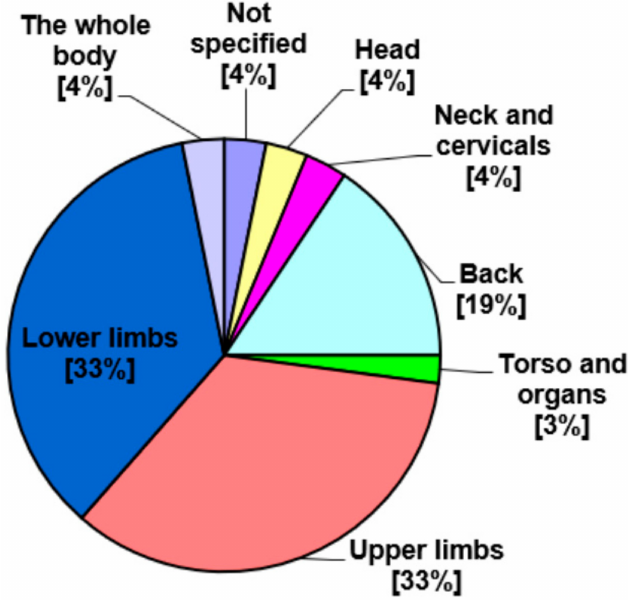
Figure 5. Accidents according to the anatomical region of the body affected, 2019. Source: Compiled by the authors.